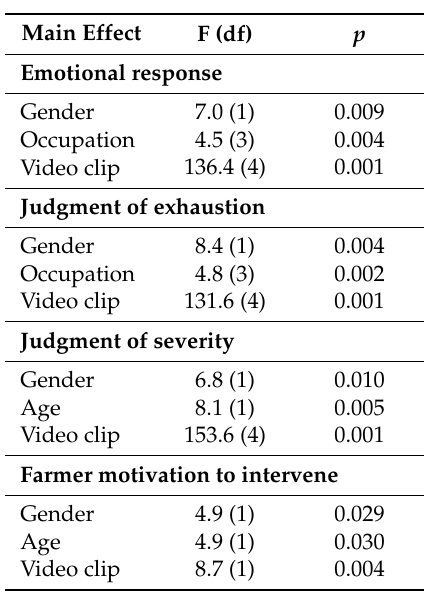
Table 7. The results of four residual maximal likelihood (REML) models investigating the factors that influence: (1) emotional response; (2) judgment of exhaustion; (3) judgment of severity and; (4) motivation to intervene. The main effects were removed from the model if p > 0.1 unless involved in a significant